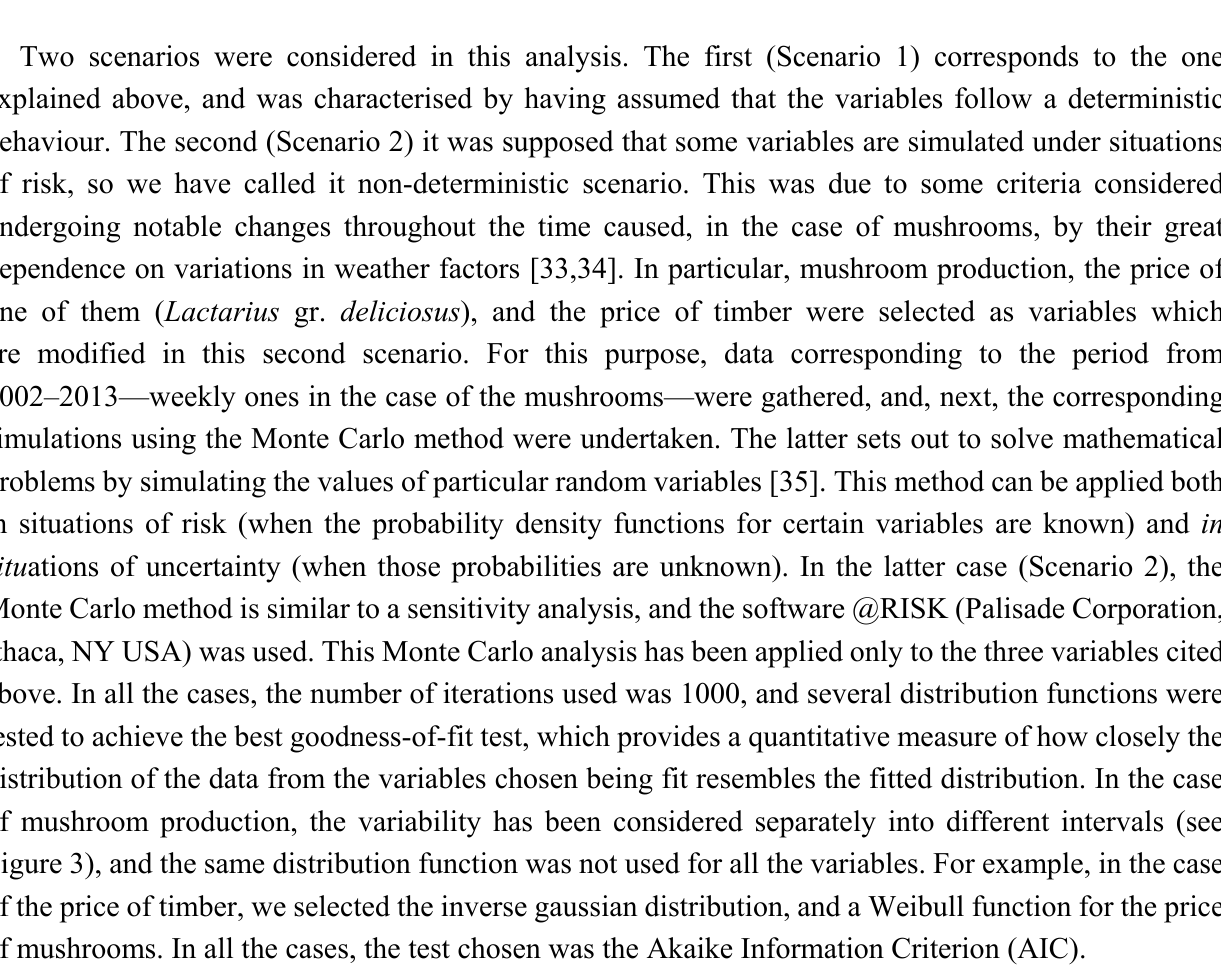
Figure 3. Mushroom production per stand-age class in period 2002–2013. (Error bars represent the standard